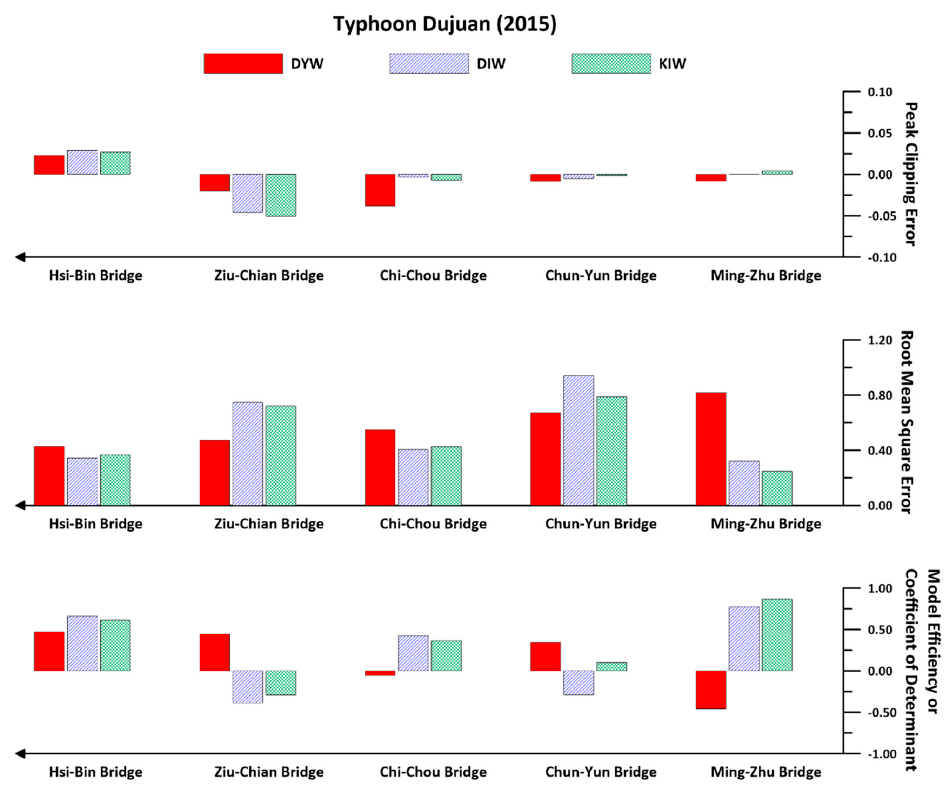
Figure 11. DYW/DIW/KIW simulations of Typhoon Megi (2016).